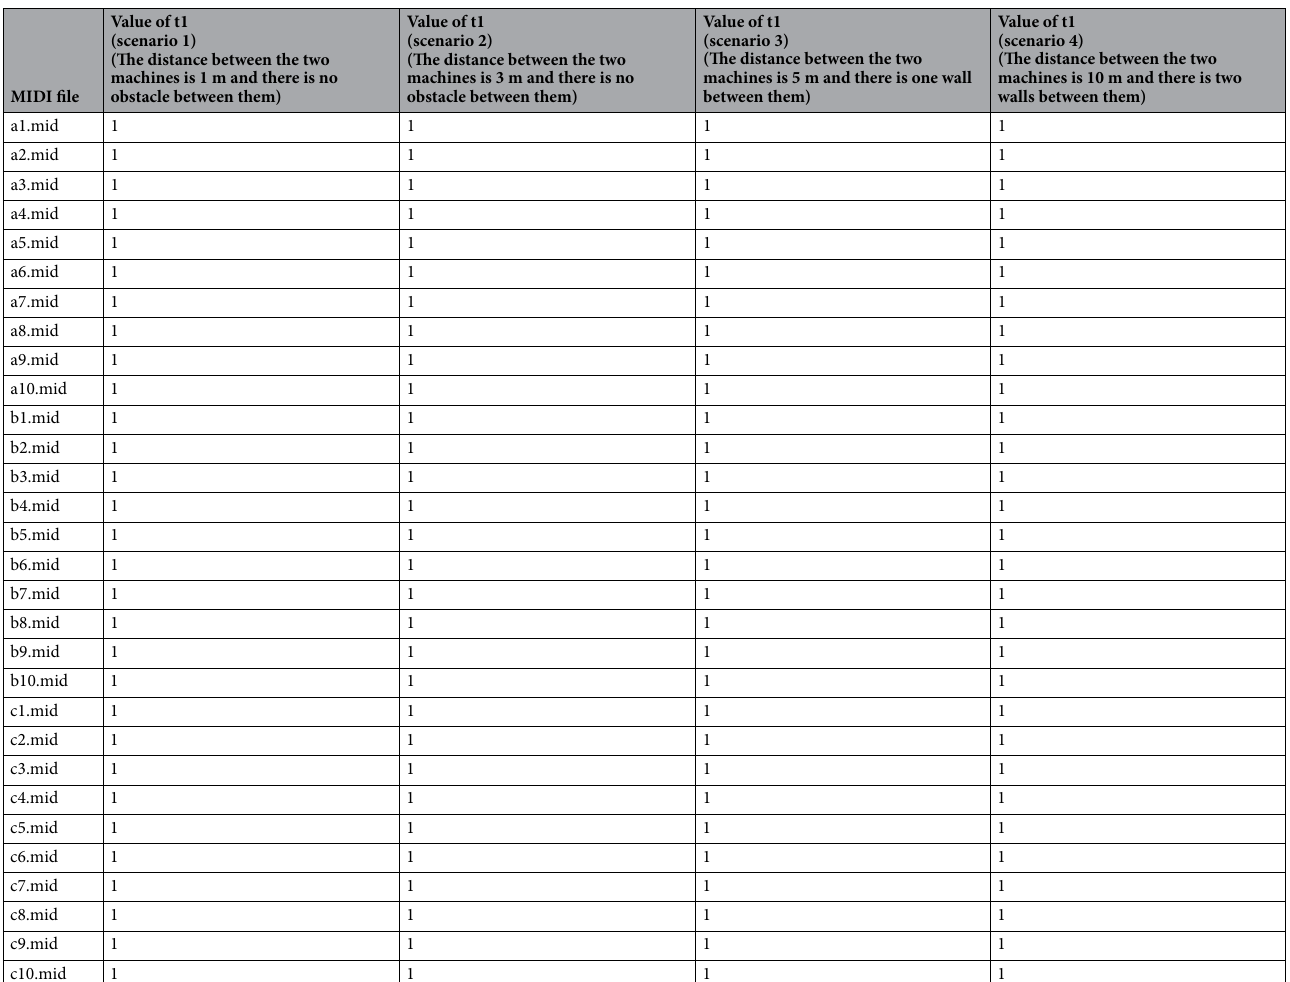
Table 6. The result of recognition when one machine plays MIDI files with a loudspeaker and another machine picks up the sound and tries to recognize it using Bideyuanli (the average decibels d1 measured at the pickup remain unchanged, the average decibels d2 measured at the loudspeaker change, and the background noise is d3 decibels) Let t1 = m/n if a URL has n characters and m characters are recognized correctly, as well as t2 = d1-d3 =